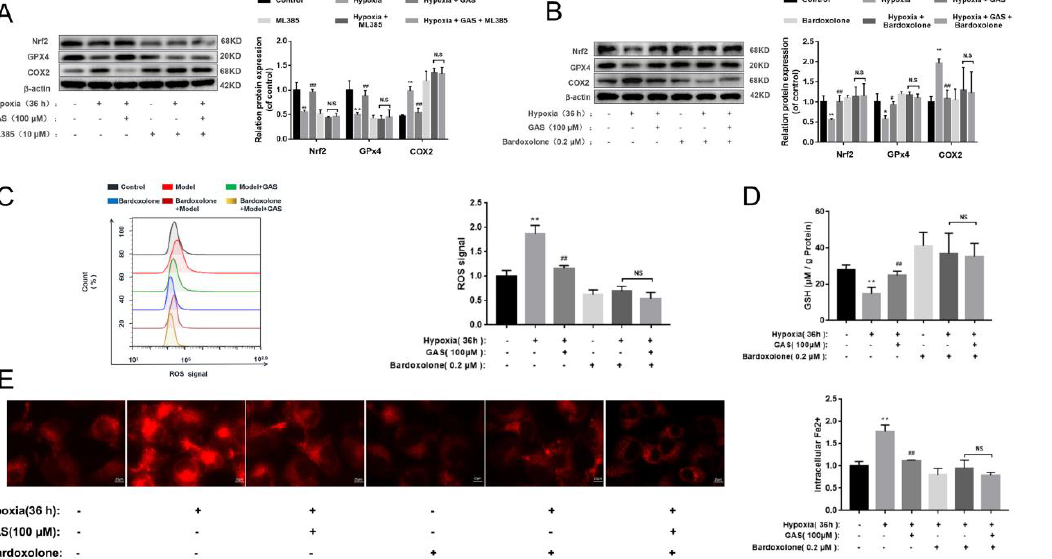
Figure 7. GAS ameliorates cognitive dysfunction in VaD rats by suppressing ferroptosis via the reg- ulation of the Nrf2/Keap1-GPx4 signaling pathway. The illustration represents how the GAS up- regulates the Nrf2 gene, promotes Nrf2 release from the complex of Keap1 and Nrf2. Then, Nrf2